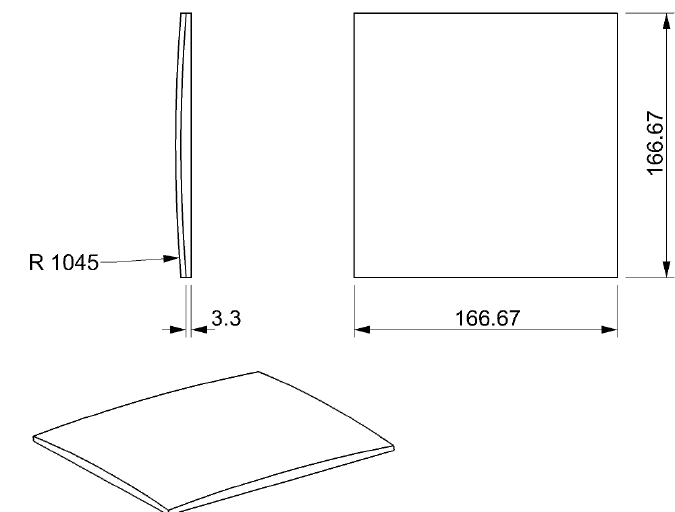
Figure 1. The “Spheric” impact pad.